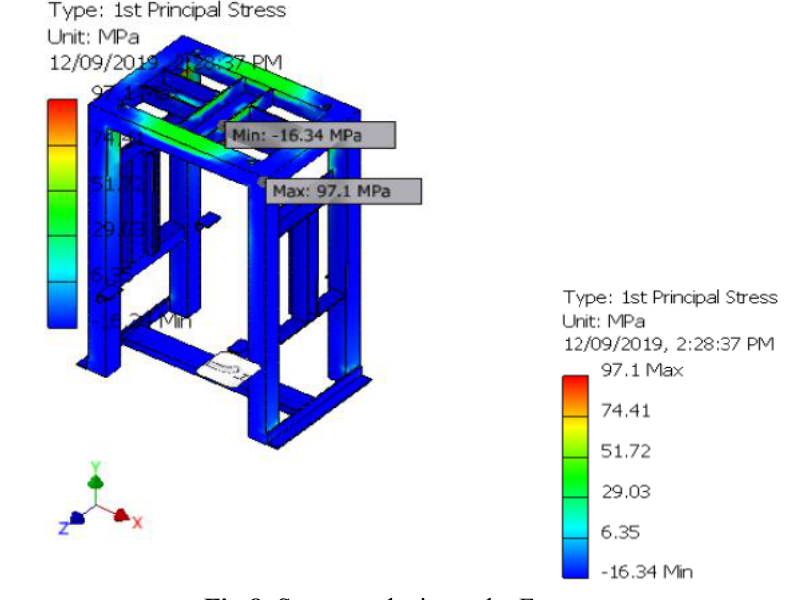
Fig.8. Stress analysis on the Frame.